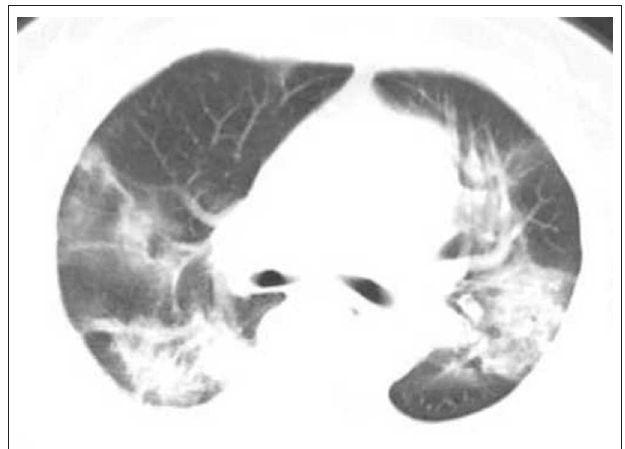
FIGURE 4 | Female, 56 years, with fever pending investigation. HRCT plain scan axial lung window showing lesions in bilateral lung lobes at the first time. The same patient was re-examined after 10 days, and the lesion range was further enlarged, showing the critical type lesion.